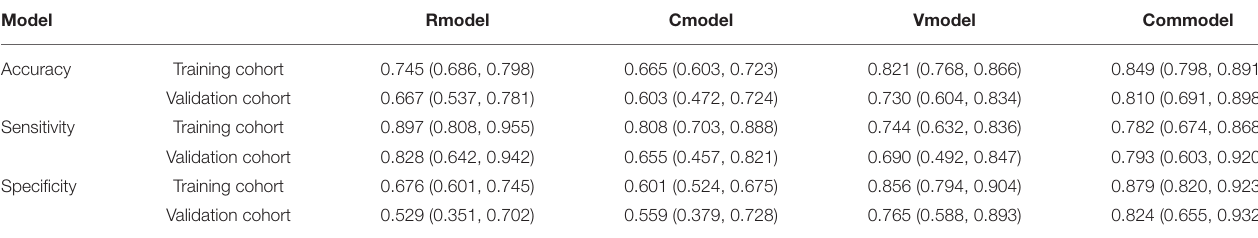
TABLE 5 | The performance of all the four models for differentiating the AF subtype. Model